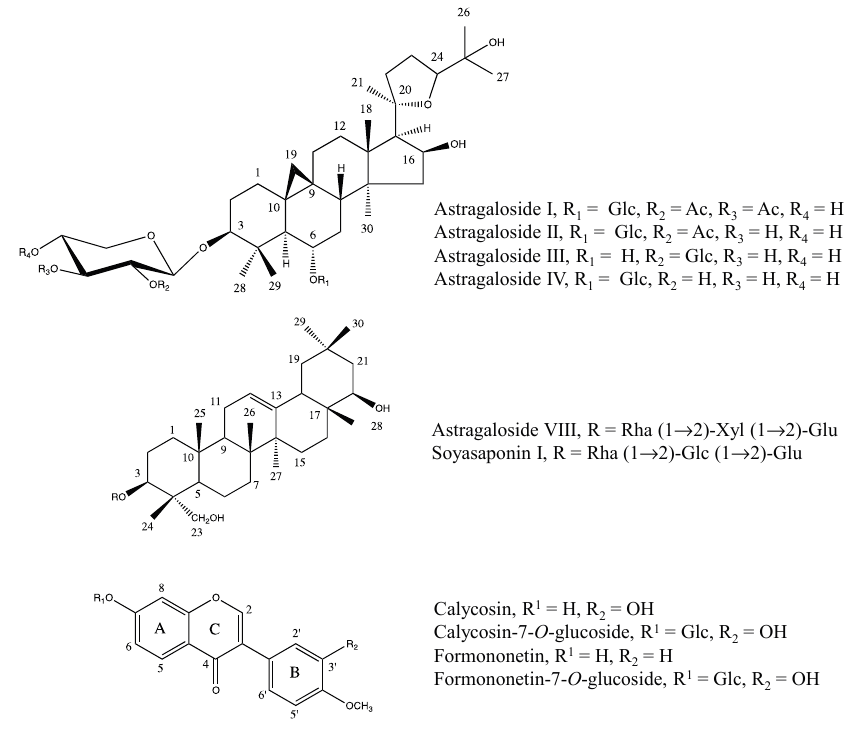
Figure 1. Chemical structures of typical saponins and flavonoids of Astragalus